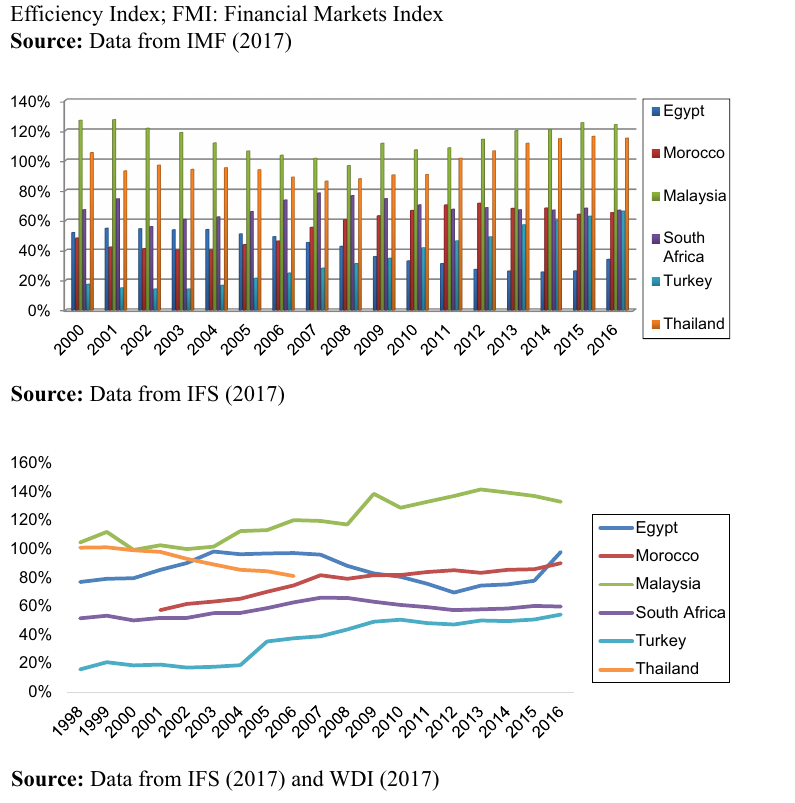
Figure 2. Financial